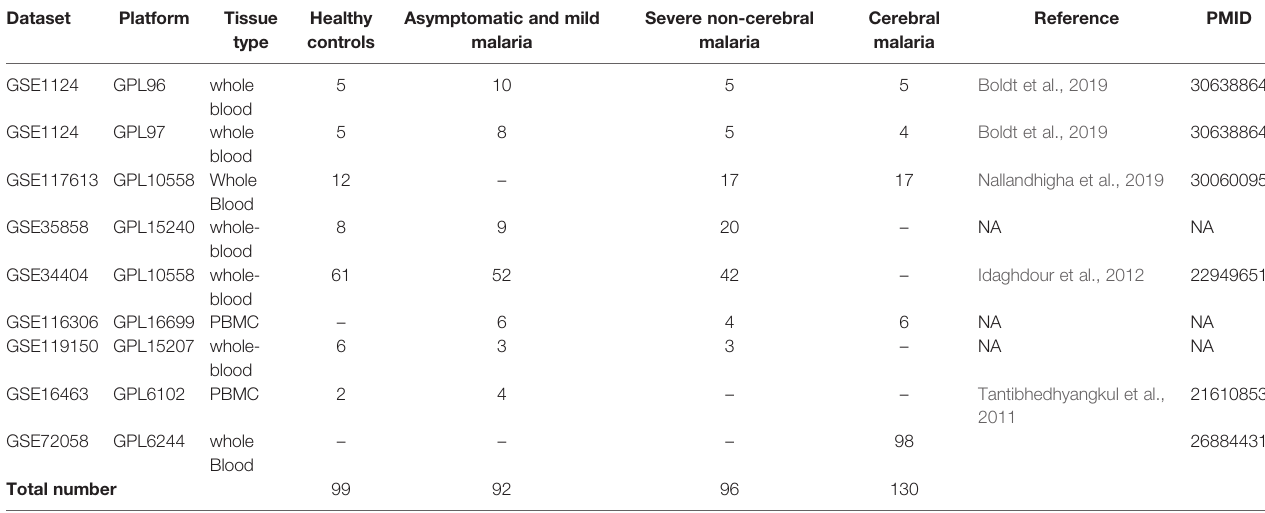
TABLE 1 | Summary of the datasets integrated in the meta-analysis pipeline for prediction and validation of the gene signature. Dataset